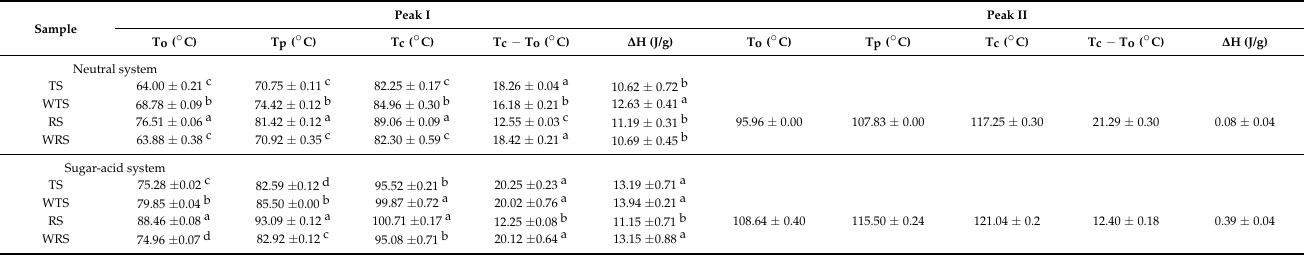
Table 3. Gelatinization properties of native starches.